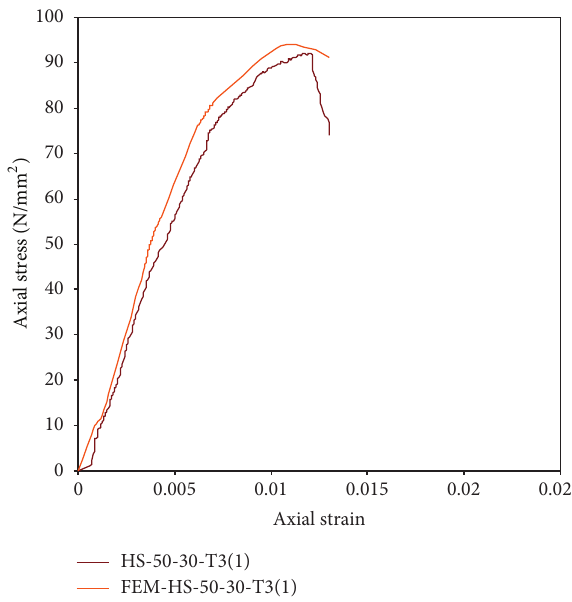
Figure 35: Comparison of experimental and computed axial stress-strain behaviours of HS-50-30-T3 (1) columns.